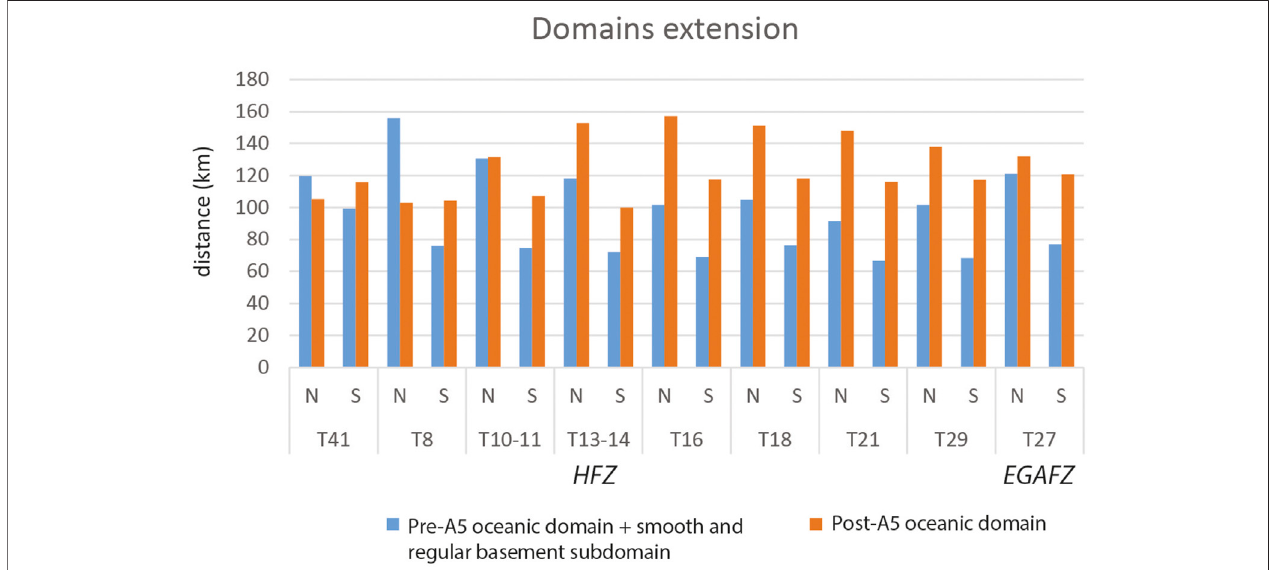
FIGURE10| This fi gurerepresentsandcomparesthewidths(inkm)ofthetwomaindomains observedintheoceanicdomainforeachseismictransect:pre-A5(+ smooth and regular basement subdomain) and post-A5 oceanic domains. For each seismic transect, the width of each domain on the north and south fl anks is compared to observe the symmetry or asymmetry. Note the strong asymmetry of the post-A5 domain close to the interpreted HFZ. The pre-A5 domain shows also a short asymmetry, with the south fl anks shorter than the north fl anks.